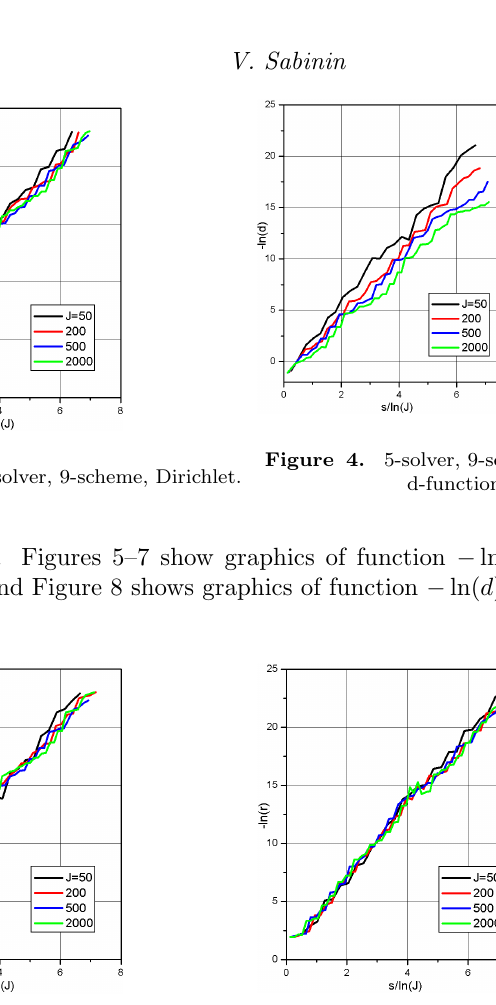
Figure 5. 5-solver, 5-scheme, Neumann. Figure 6. 9-solver, 9-scheme, Neumann. Figure 5 corresponds to the variant of the 5-point solver and the 5-point FD scheme (2.2). Figure 6 corresponds to the variant of the 9-point solver and the 9-point FD scheme